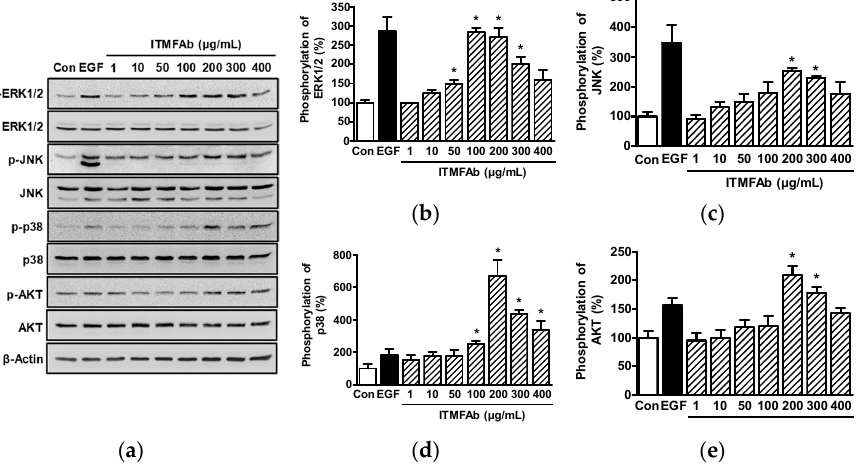
Figure 4. Effect of Impatiens textori Miq. flower absolute on the activation of kinases in HaCaT cells. HaCaT cells were incubated with or without Impatiens textori Miq. flower absolute (ITMFAb; 1–400 µg/mL) for 10 min and cell lysates were immunoblotted with the indicated antibodies. ( a ) Repre-